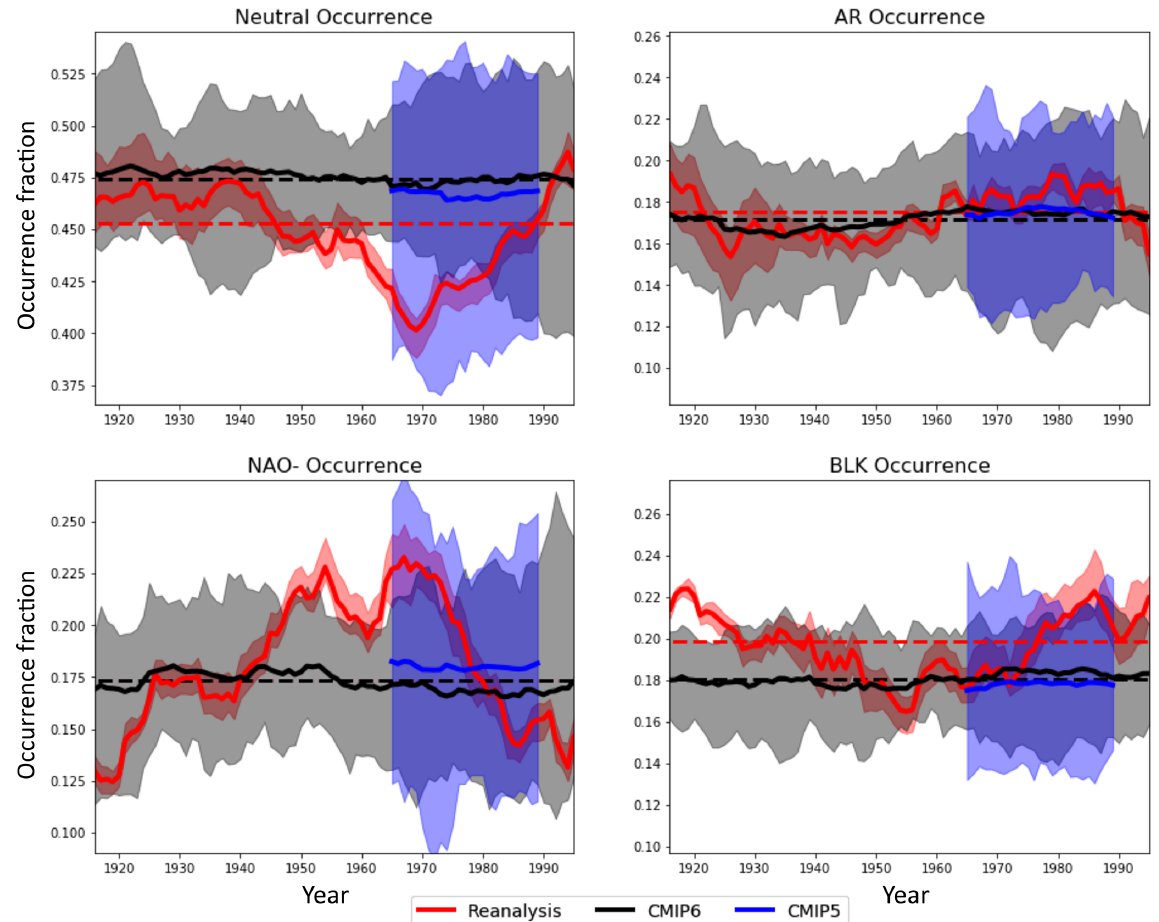
Figure 10. The 30-year rolling windows of regime occurrence for the multi-reanalysis, CMIP5, and CMIP6 ensembles, with the x axis marking the central year of the window. Thick lines show the ensemble mean, while shading indicates the spread between the maximum and minimum values in the ensemble. Dashed red and black lines show the 1900–2010 average occurrence for reanalysis and CMIP6 respectively. Figure S11 shows the number of datasets included for each 30-year